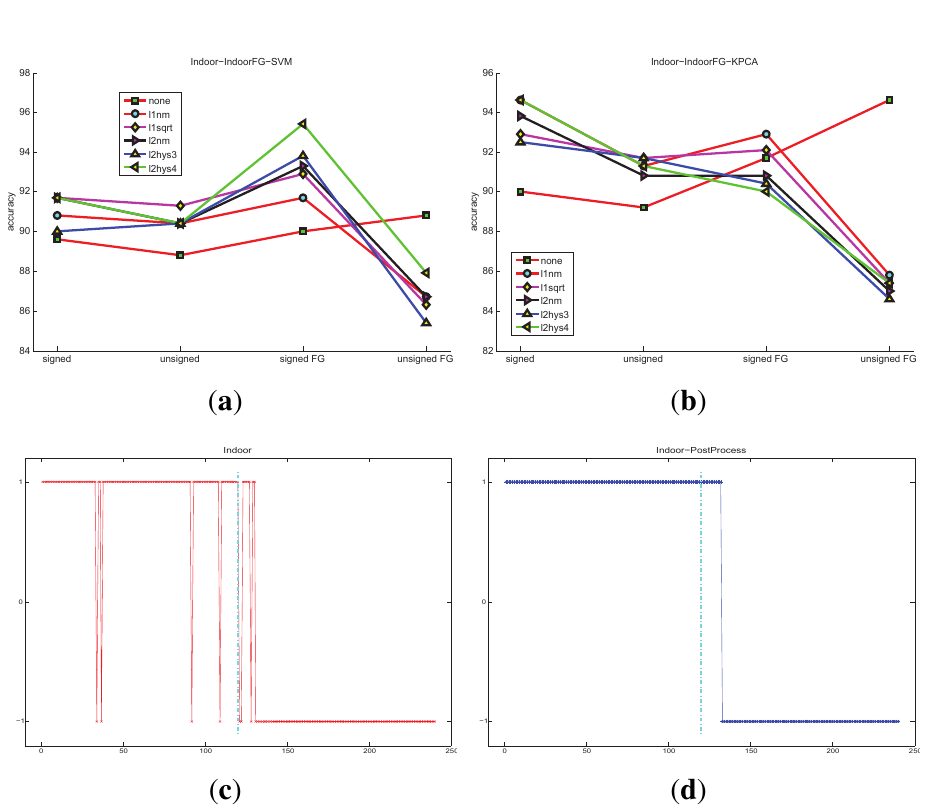
Figure 10. The accuracy of the indoor scene under different classification methods and different features: ( a ) HOFO descriptors are computed on the original image and the foreground image; one-class SVM is taken as the classification method, the maximum accuracy is 95 . 4% ; ( b ) HOFO descriptors are computed on the original image and the foreground image; KPCA is taken as the classification method; ( c ) original detection results, the maximum accuracy is 94 . 6% ; ( d ) detection results that are post-processed by the state transition restriction strategy; the consecutive frame number threshold is N = 3 . 250 frames are used for training; 120 frames are used for normal and abnormal testing,